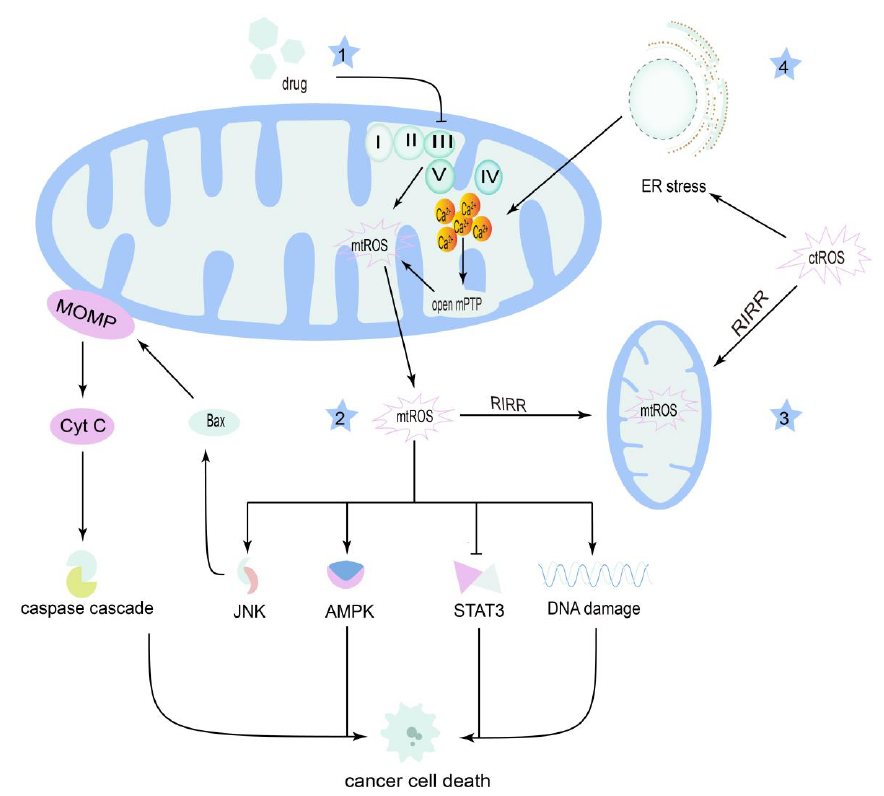
Figure 3. Reactive oxygen species (ROS) in OSCC therapy. (1) Drugs can induce the upregulation of mitochondrial reactive oxygen species (mtROS) by inhibiting the electron transport chain (ETC). (2) Those mtROS can suppress cancer cell survival by activating the c-Jun N-terminal kinase (JNK) and AMP-activated protein kinase (AMPK) pathways while inhibiting the signal transducer and activator of the transcription 3 (STAT3) pathway, causing DNA damage. (3) MtROS can be induced by mtROS and cytoplasmic reactive oxygen species (ctROS) via ROS-induced ROS release (RIRR). (4) CtROS can cause endoplasmic reticulum (ER) stress, resulting in a surge of Ca 2+ in the mitochondria, and subsequently increased mtROS induced by the open of mitochondrial permeability transition pore